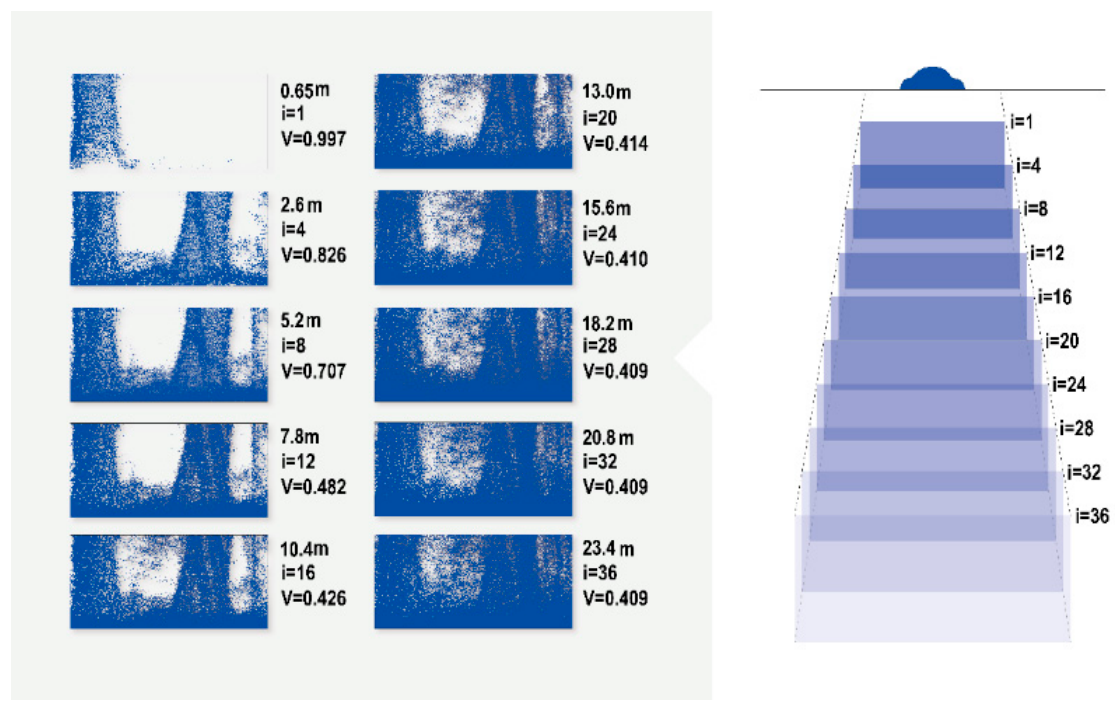
Figure 3. A sample of the minimum enclosing rectangle used to calculate visibility. Data were obtained from sample 2021-05-18-12-01-28, θ = 4. The blue portion of each minimum enclosing rectangle indicates the area (n θ ,i ) obscured by the projection of the point cloud. The white portion indicates the exposed area, which indicates visibility.